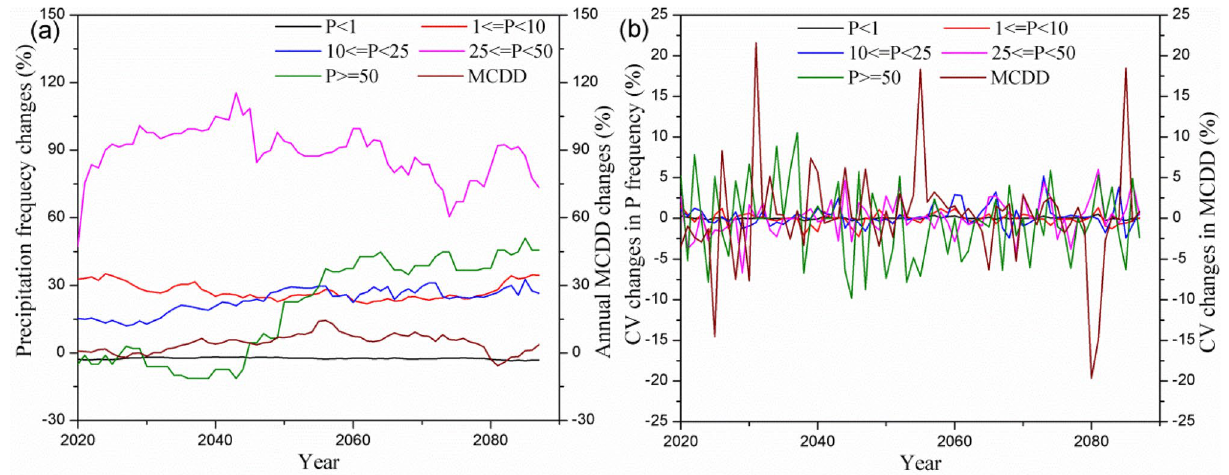
Figure 3. Ensemble average percentage changes in maximum consecutive drought days (MCDD) and precipitation frequency of different rainfall patterns ( a ) and their CV values ( b ) throughout 2020–2099 under the RCP 8.5 scenario compared to the baseline period. The changes were calculated as running average for each 25 years corresponding to 1980–2004. Graphs were created using OriginPro software version 9.0 (https:// www. origi nlab.